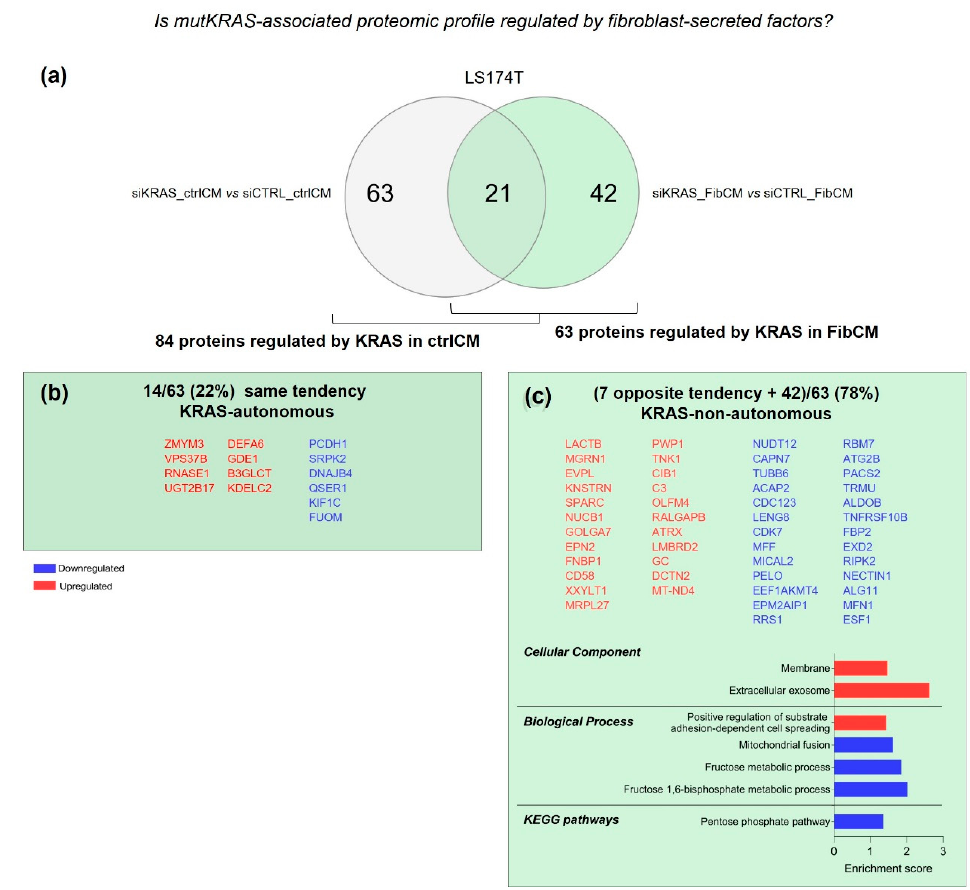
Figure 5. KRAS—autonomously and non-autonomously controlled proteins in LS174T cells . ( a ) Venn diagram showing the number of exclusive and common proteins identified in the ana- lyzed conditions (siKRAS_ctrlCM vs. siCTRL_ctrlCM and siKRAS_FibCM vs. siCTRL_FibCM). ( b , c ) GO and KEGG pathways analysis of shared proteins following the same expression tendency (KRAS-autonomous) showed no significant results ( b ), and of shared proteins with opposite expres- sion tendencies together with exclusive proteins from the comparison siKRAS vs. siCTRL cultured in FibCM (KRAS-non-autonomous) ( c ). Protein lists are organized according to the abundance ratio. The enrichment score was calculated by—log p